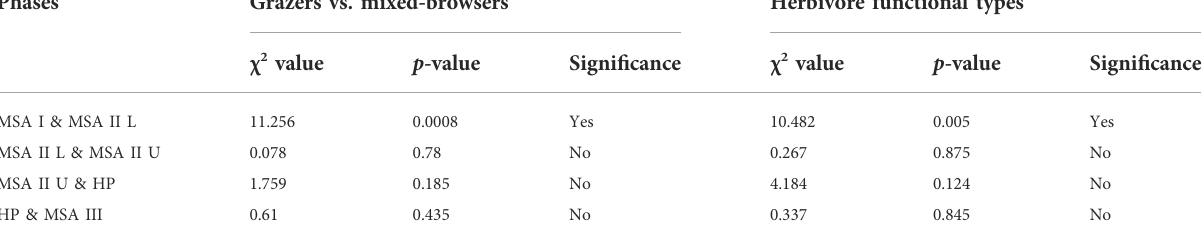
TABLE 4 Chi-squared tests of signi fi cance for ungulate categories at Klasies River. ‘ Mixed-browsers ’ are mixed-and intermediate feeders and browsers. Herbivore functional types based on Hempson et al. (2015). Phases Grazers vs. mixed-browsers Herbivore functional types